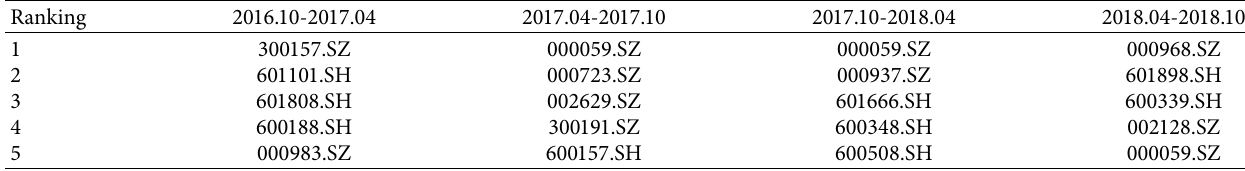
Table 6: Importance analysis of complex network nodes based on closeness centrality.